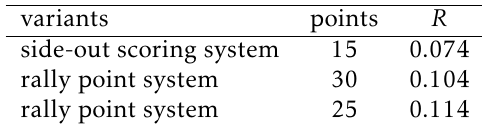
Table 9. game refinement value for three variants of Volleyball.